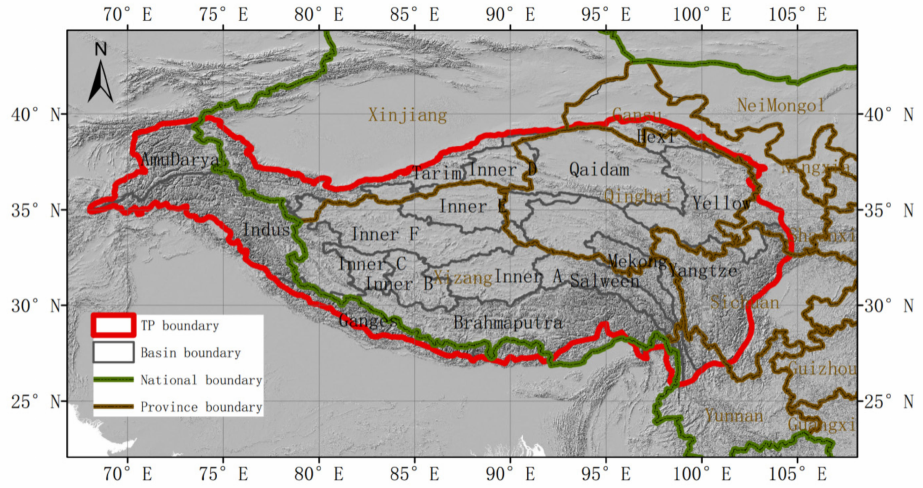
Figure 1. Geographical distribution of 12 basins of the Tibetan Plateau overlaid on a hillshade digital elevation model